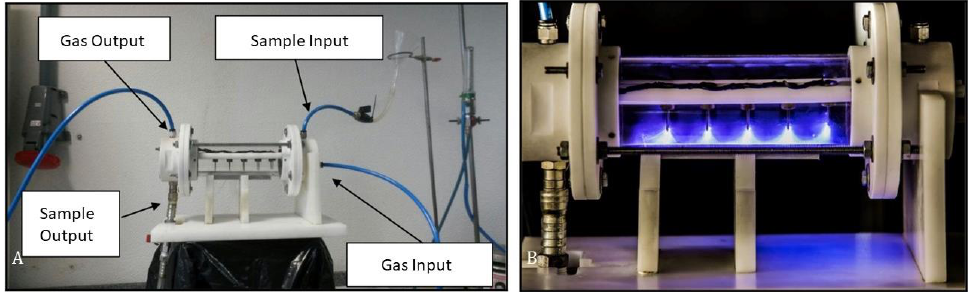
Figure 1. Non-thermal plasma reactor ( A — NTP system; B — NTP in operation). Source: The au- thors.